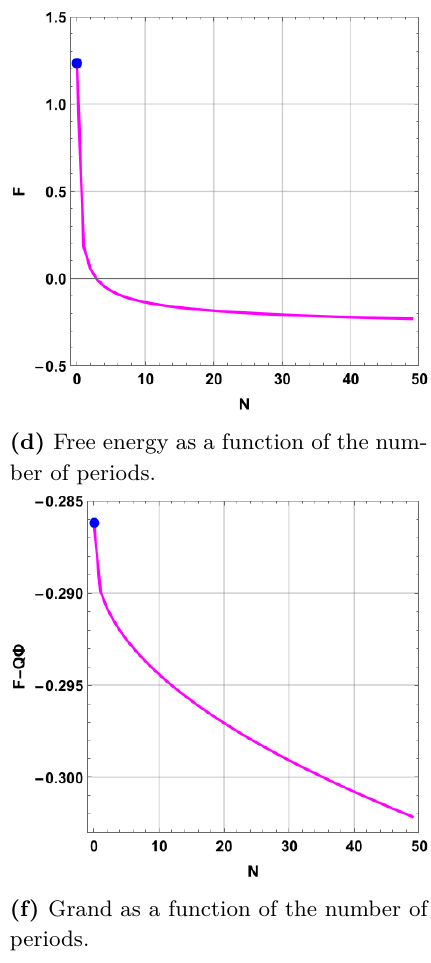
Figure 16. Evolution of different thermodynamic potentials during an absorption of 10 5 particles over 50 periods. The initial conditions (blue dot) are Q = 1 , l = 1 , M = 1 . 23 , r h = 0 . 65 , and D = 4